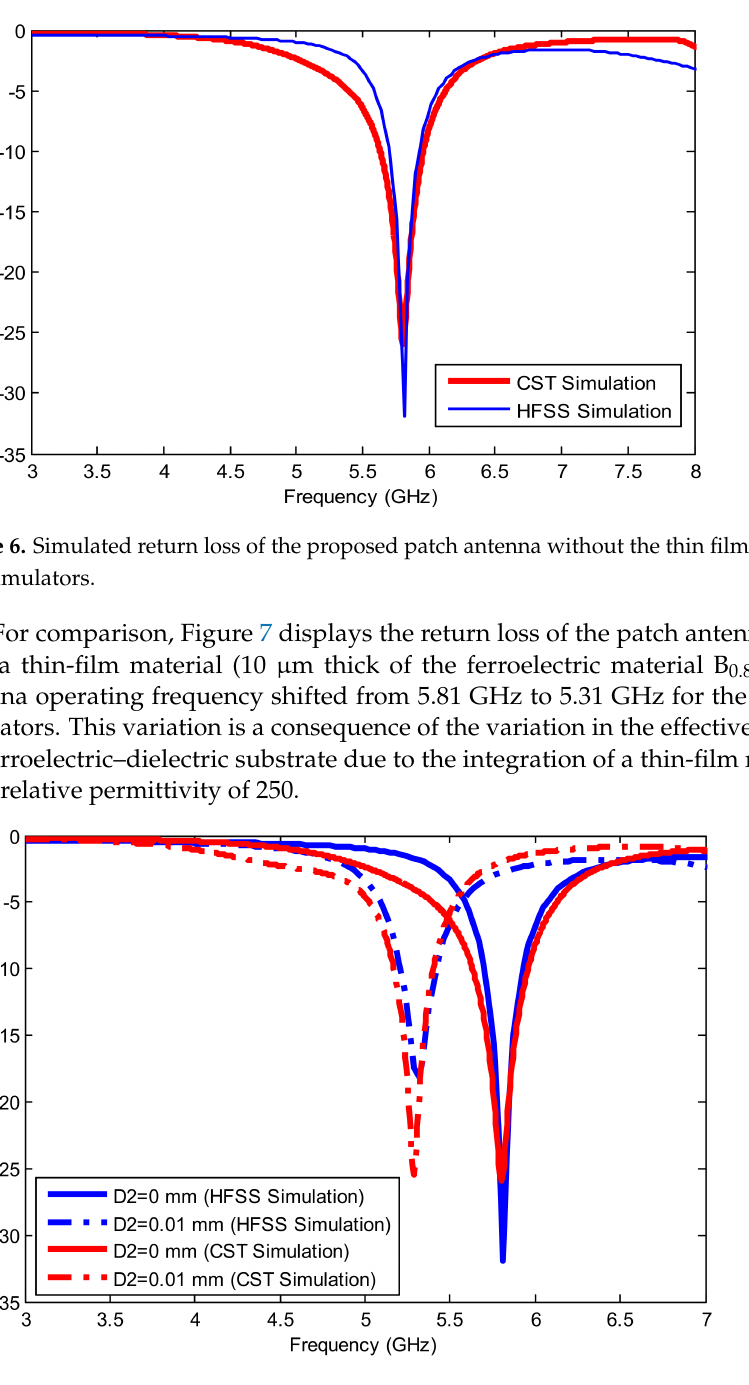
Figure 7. The simulated return loss of the patch antenna without and with a thin film of the ferroelectric material BST for HFSS and